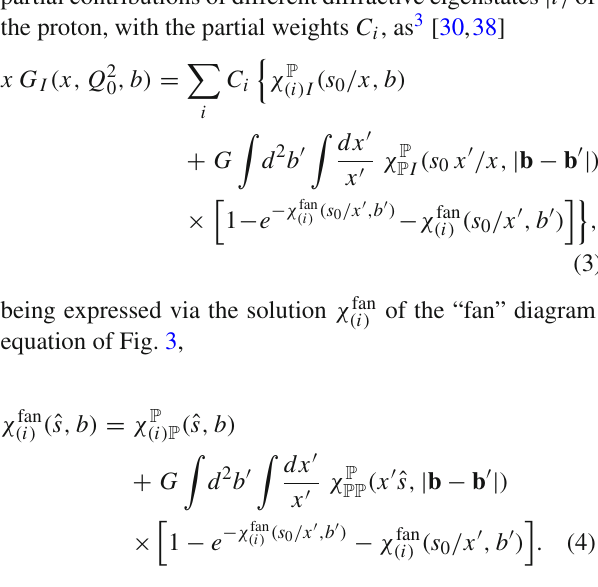
Fig. 3 Recursive equation for a fan diagram contribution χ fan ( ˆ s = s / 0